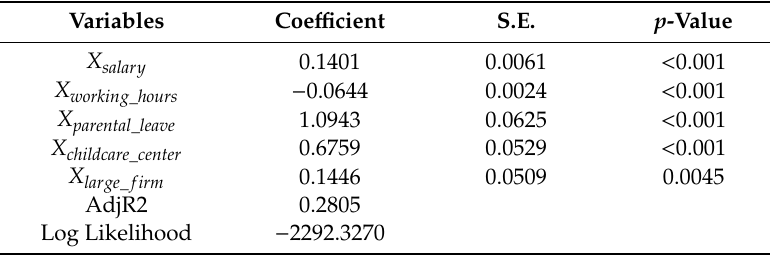
Table 5. Estimation results of the indirect utility